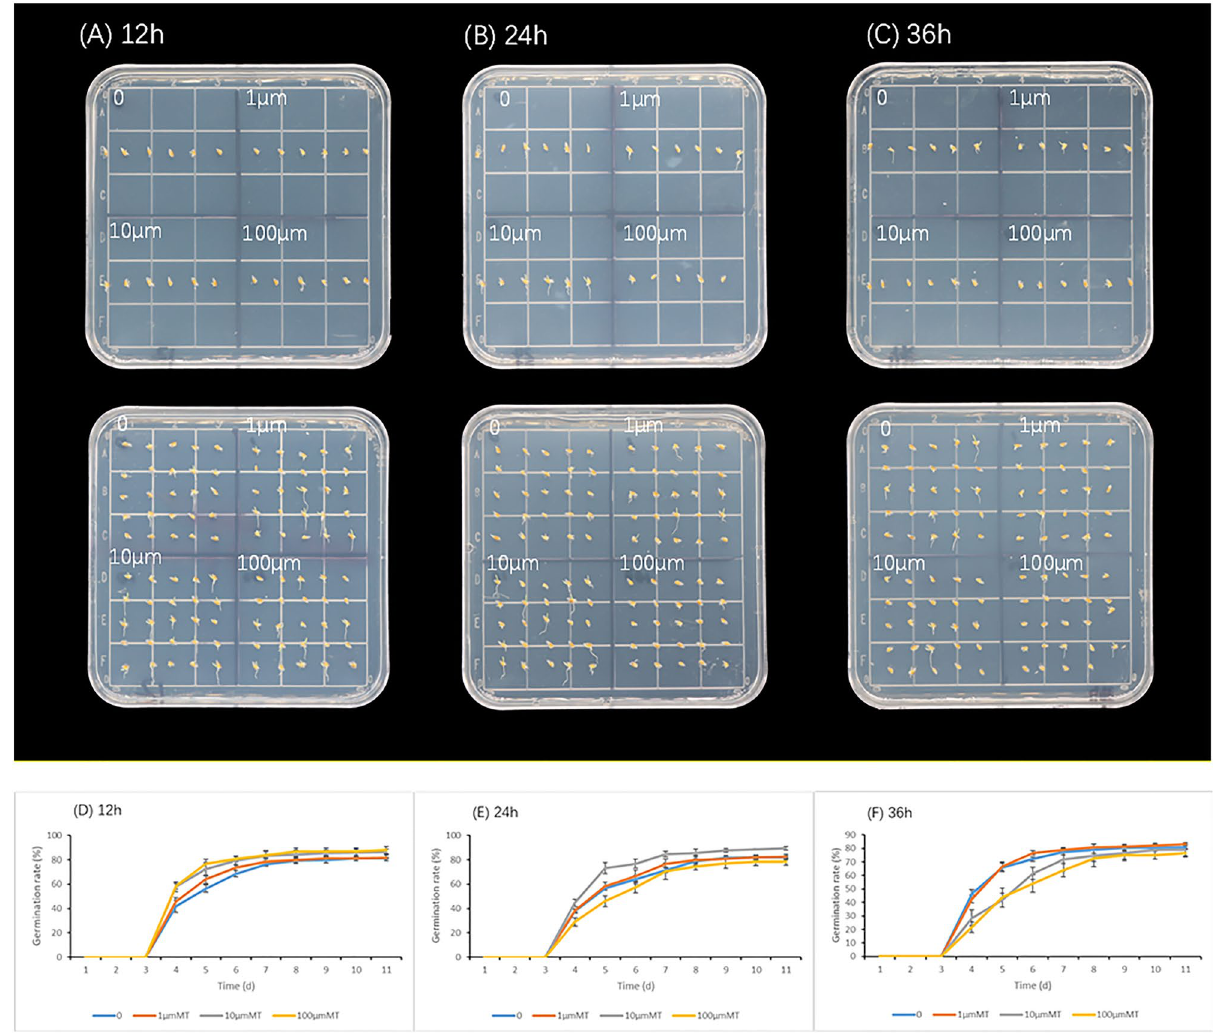
Figure 1. Seed of zoysia with different soaking times. Zoysia seeds were immersed in water and 1, 10, 100 μm melatonin solution for 12 ( A ), 24 ( B ), 36 ( C ) hours, respectively. The Germination rates of seeds zoysia soaked for 12 ( D ), 24 ( E ), 36 ( F ) hours were shown. Blue, red, gray, and yellow represent seeds treated with water, 1, 10, 100 μm melatonin, respectively. 24 h immersion in 10 μm melatonin solution was chosen as the treatment